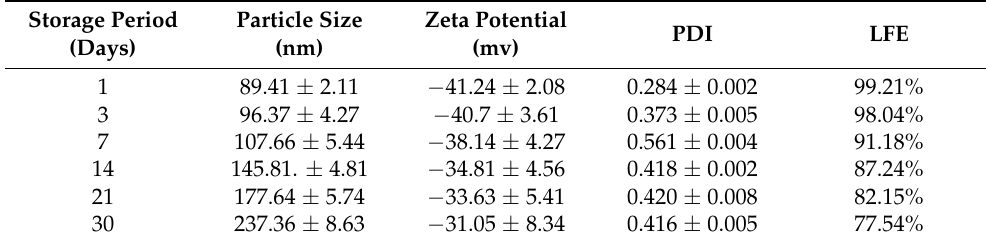
Table 4. The changes of particle size, zeta potential, poly dispersing index, and liposome formation efficiency during the storage.